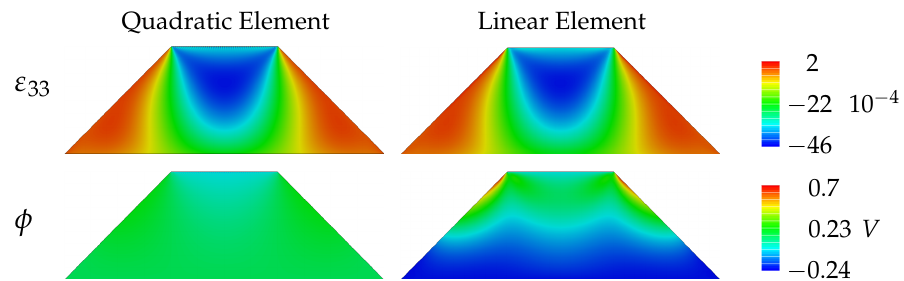
Figure 29. Contour plots for mechanical strain ε 33 and electric potential φ in the truncated pyra- mid using linear and quadratic elements. The same color scale is used for both elements for better